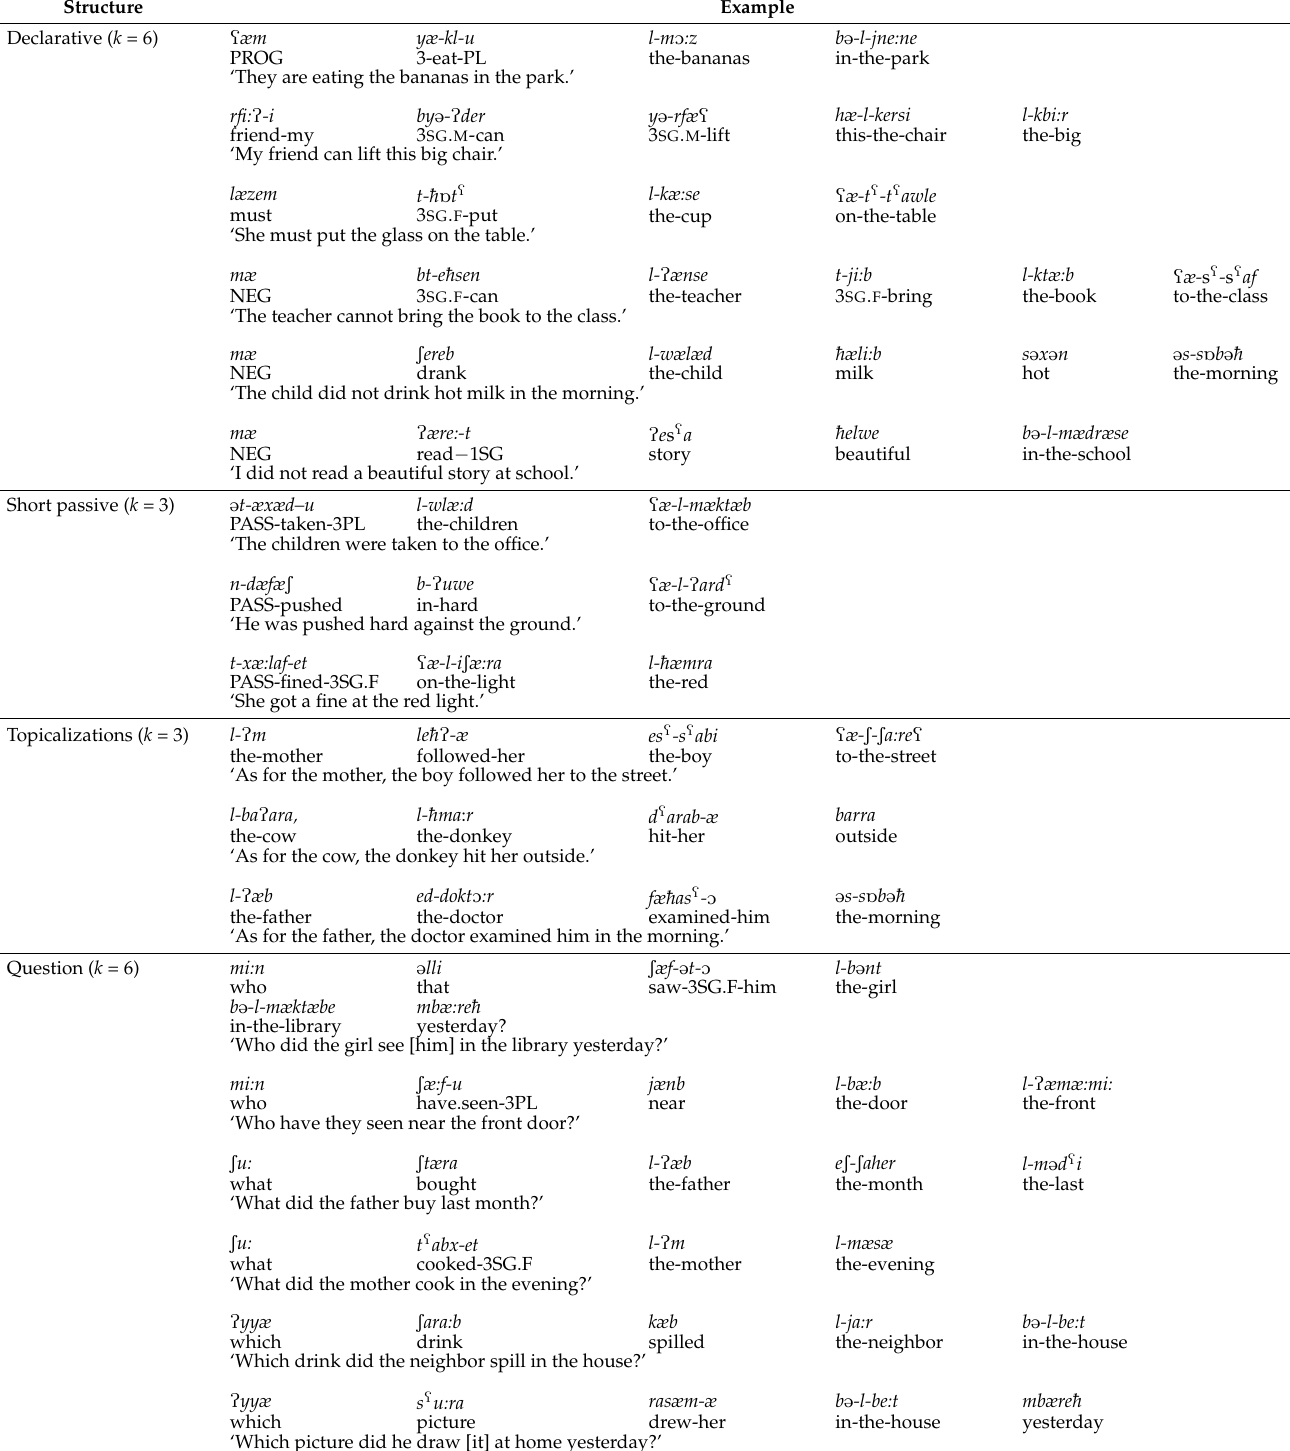
Table A2. Stimuli used in Syrian Arabic